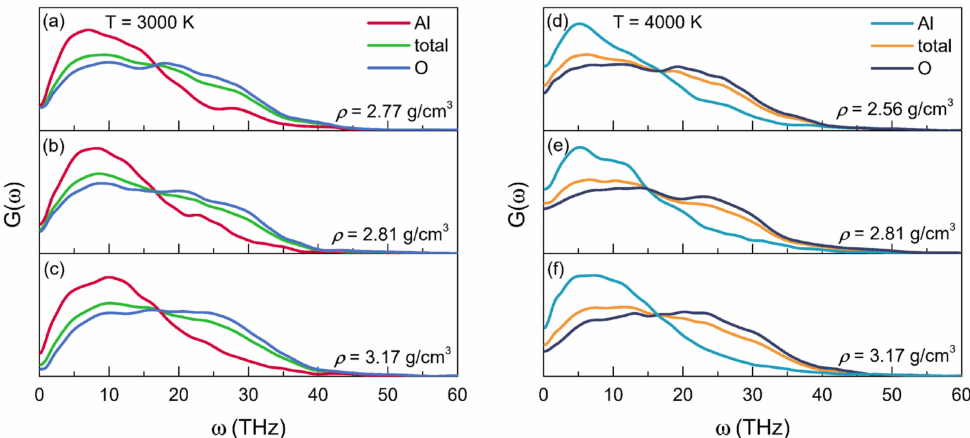
Figure 5. Partial and total vibrational density of states (VDOS) for the configurations of liquid alumina at ( a – c ) 3000 K and ( d – f ) 4000 K, with three densities at each